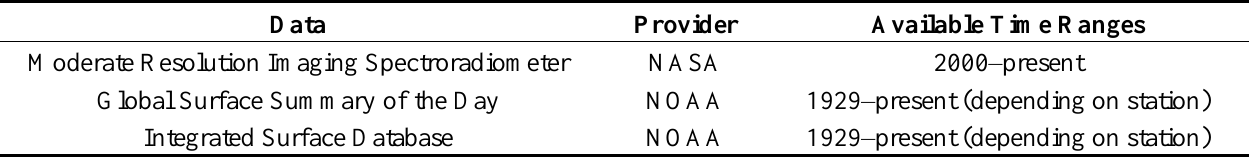
Table 1. Data sources used for operational land